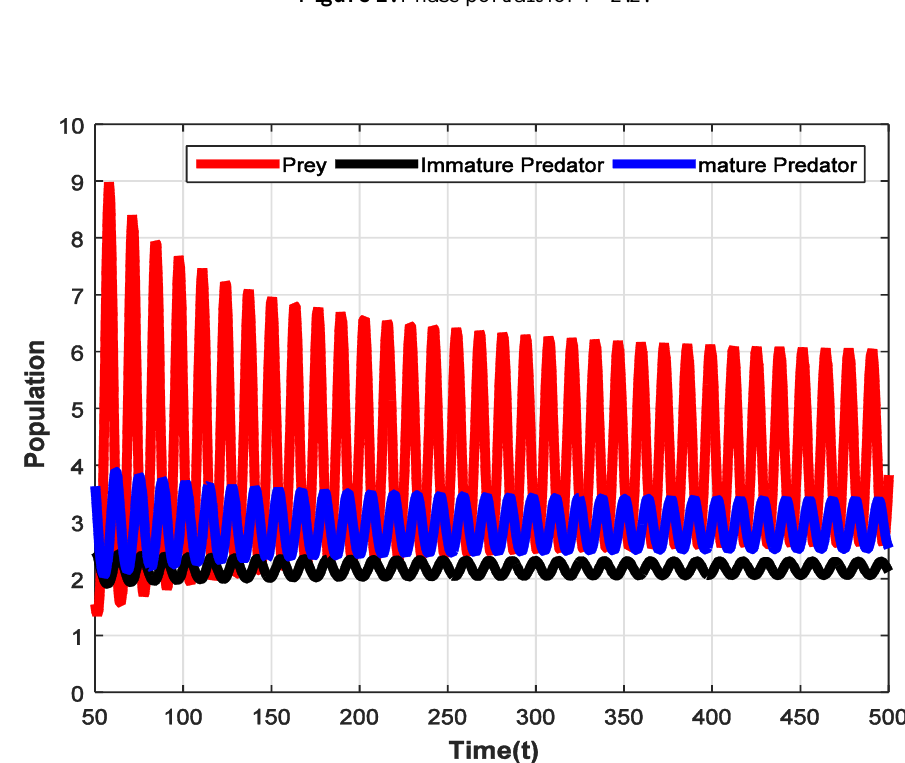
Figure 3. Population graph for